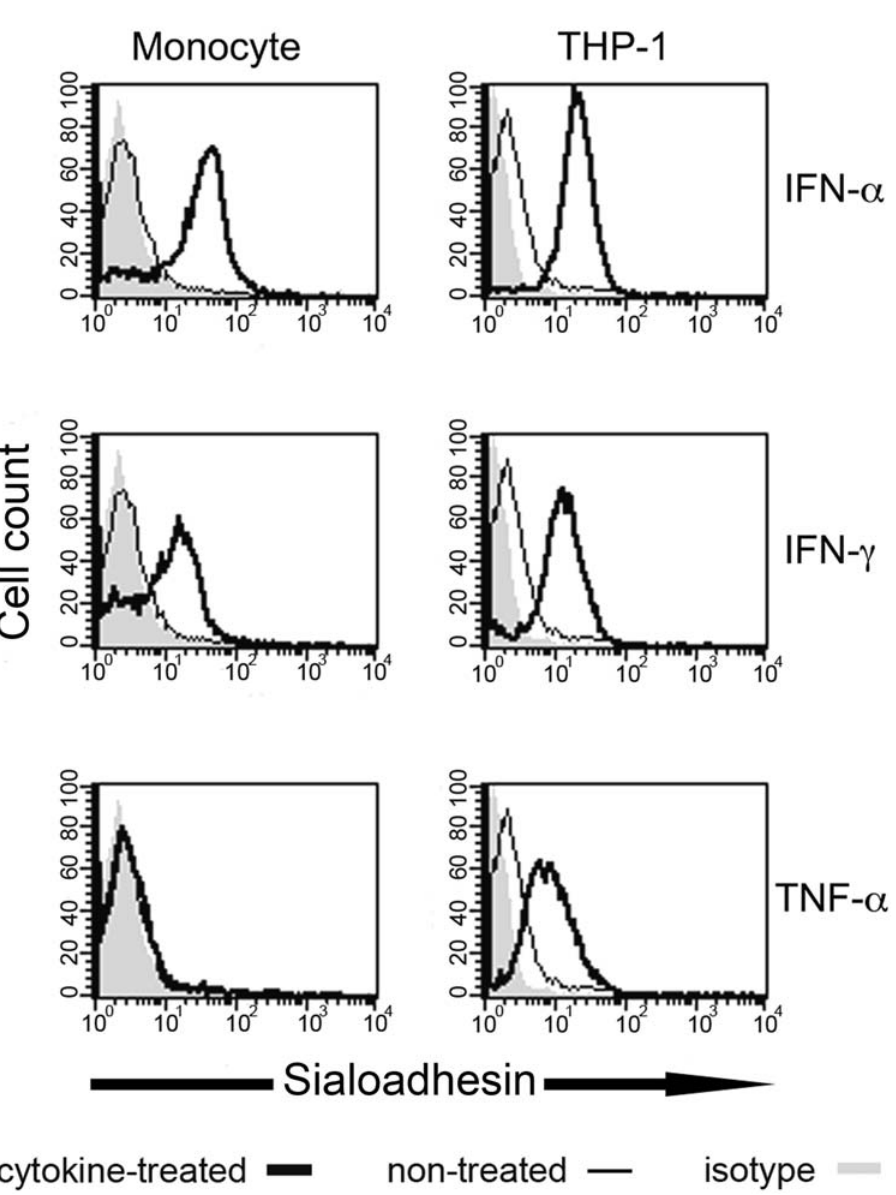
Figure 2. Interferon- a and - c induce Sn expression on CD14 + monocytes and THP-1 cells. Cells were cultured in 500 U/ml IFN- a , 100 U/ml IFN- c or 10 ng/ml TNF- a at 37 u C for 48 h and analyzed for Sn expression by flow cytometry. Sn expression on IFN- a -, IFN - c - or TNF- a -treated cells (thick black lines) and untreated cells (thin black line) were relative to an isotype-matched mAb control (shaded region). Results shown are representative histograms from three independent experiments using monocytes from three seronegative